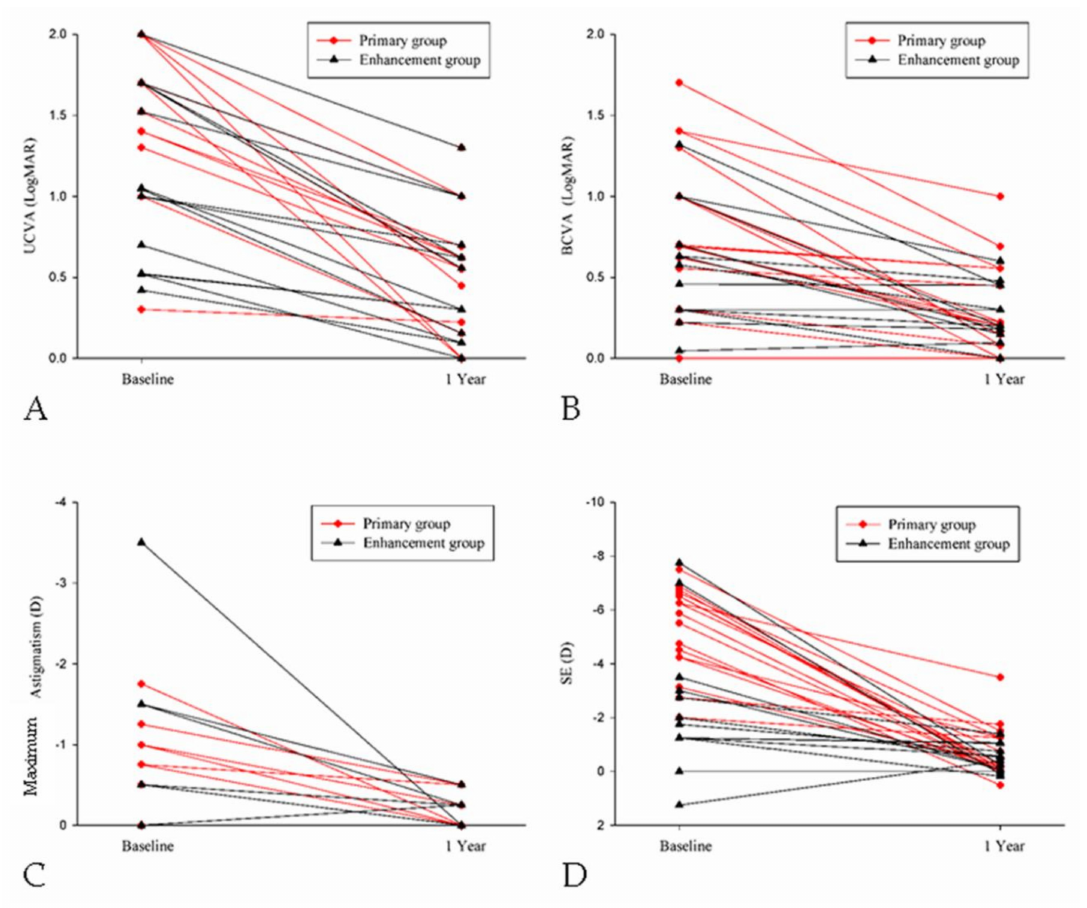
Figure 5. The changes in di ff erent parameters after the surgery for each eye in the study population. ( A ) The change in uncorrected visual acuity; ( B ) The change in best-corrected visual acuity; ( C ) The change in maximum astigmatism; ( D ) The change in spherical equivalent. UCVA: uncorrected visual acuity; BCVA: best-corrected visual acuity; SE: spherical equivalent; LogMAR: logarithmic scale of minimal angle of resolution; D: